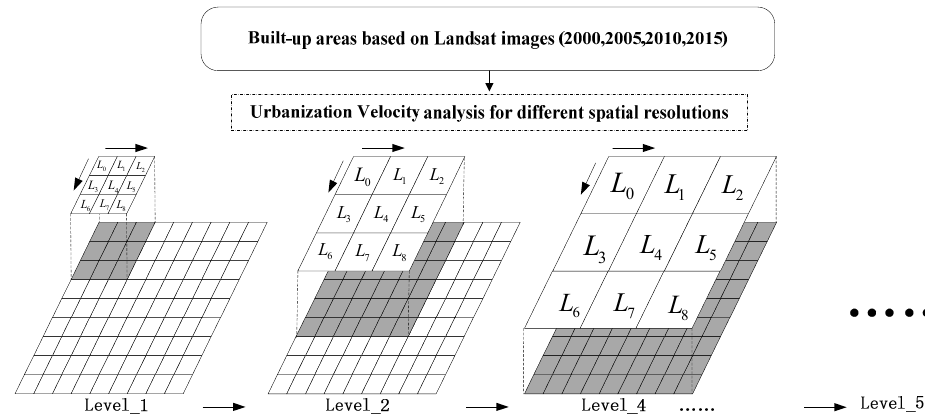
Figure 3. The hierarchy of moving windows that were employed when investigating urbanization velocity at different resolutions.